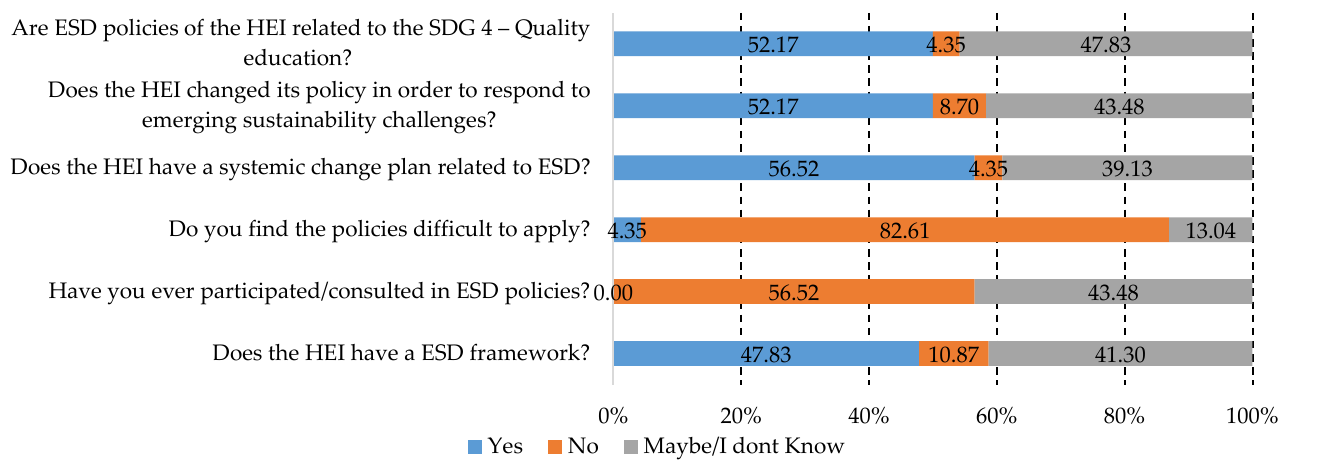
Figure 3. Priority area No. 1 results.